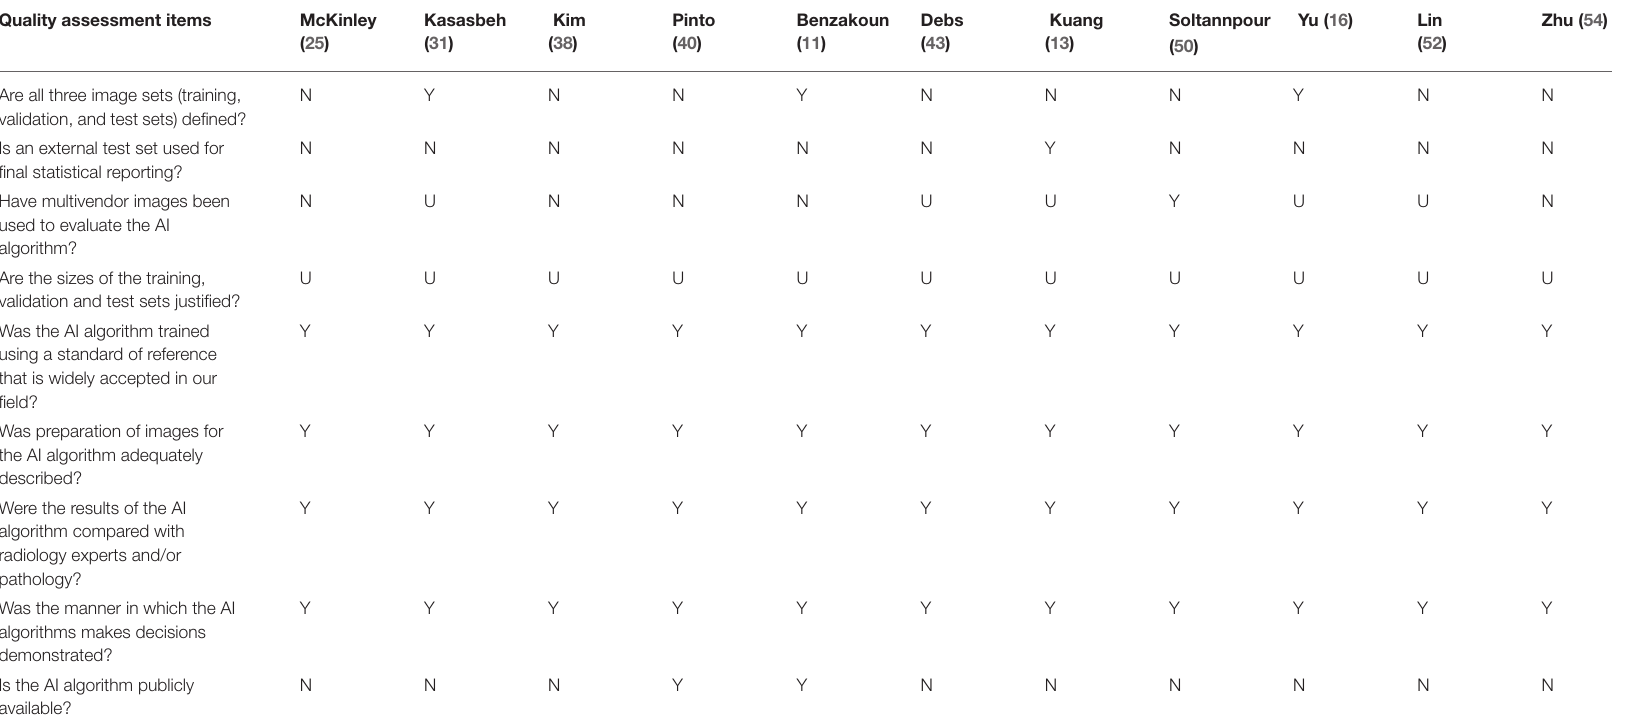
TABLE 2 | Methodological quality assessment of the included studies. Quality assessment